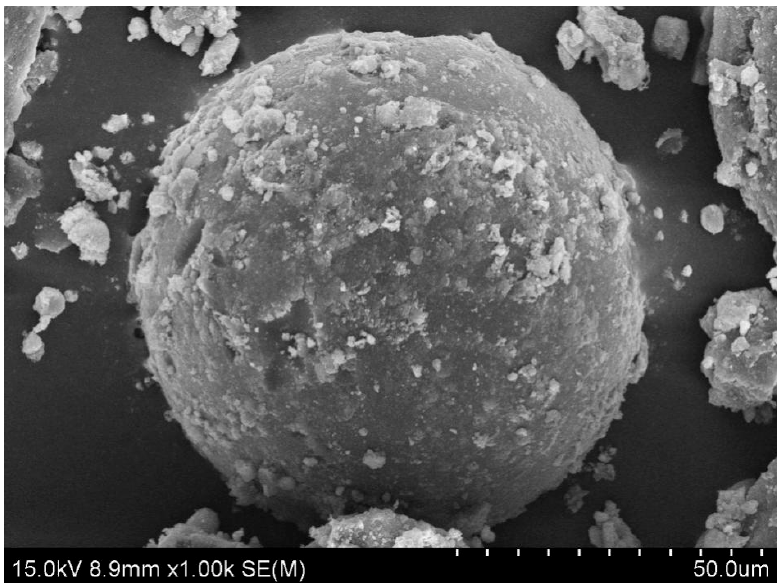
Figure 2. SEM image of γ -Fe 2 O 3